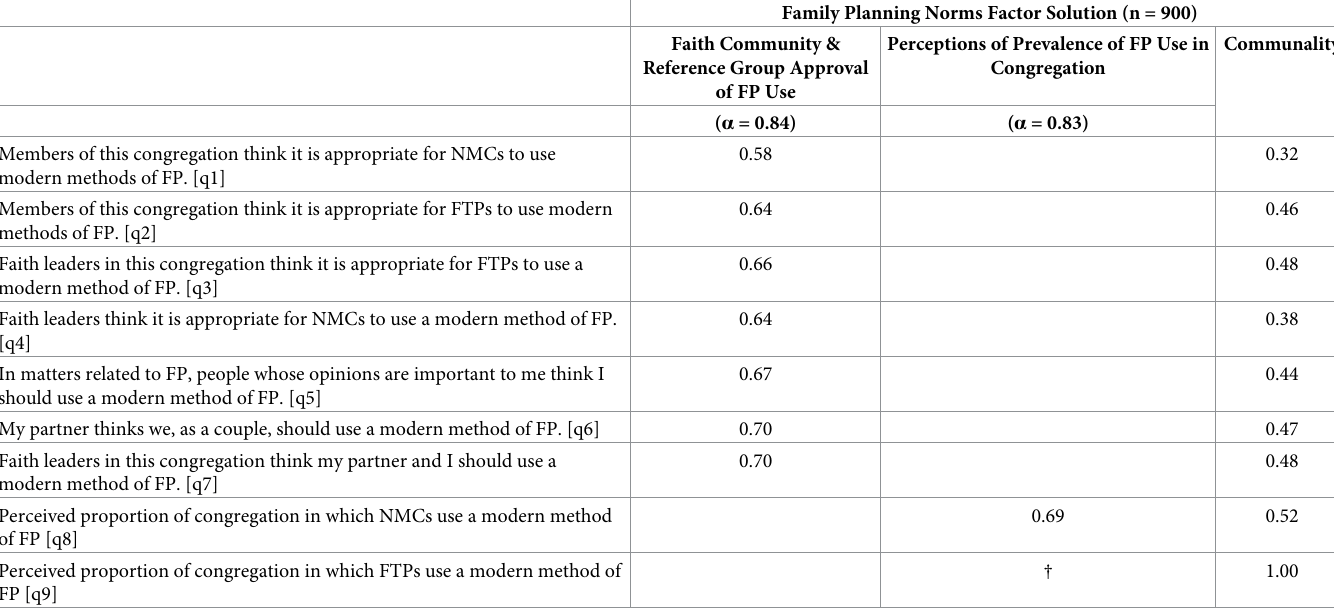
Table 4. Factor loadings and communalities based on exploratory factor analysis for items related to family planning social norms among men and